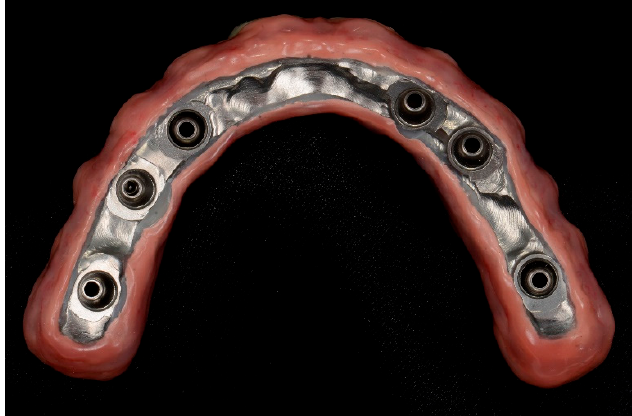
Figure 7. Prosthesis finalization in the laboratory.